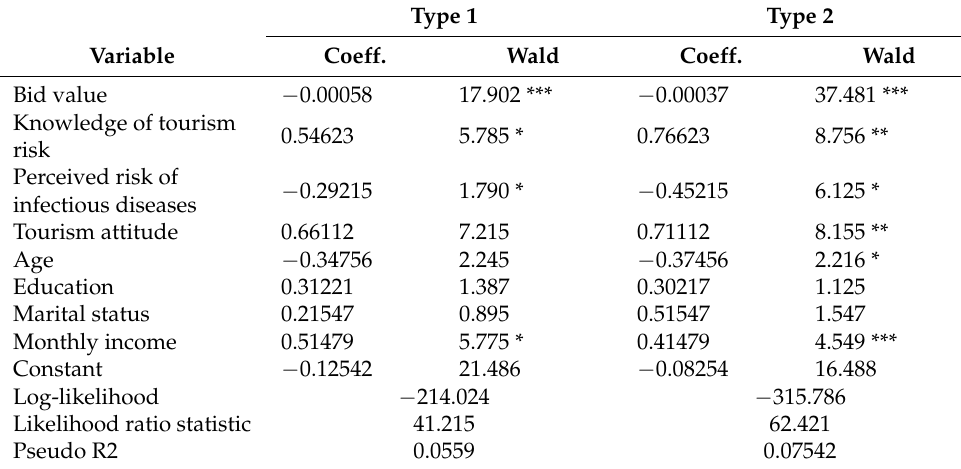
Table 5. Estimated WTP and coefficients.